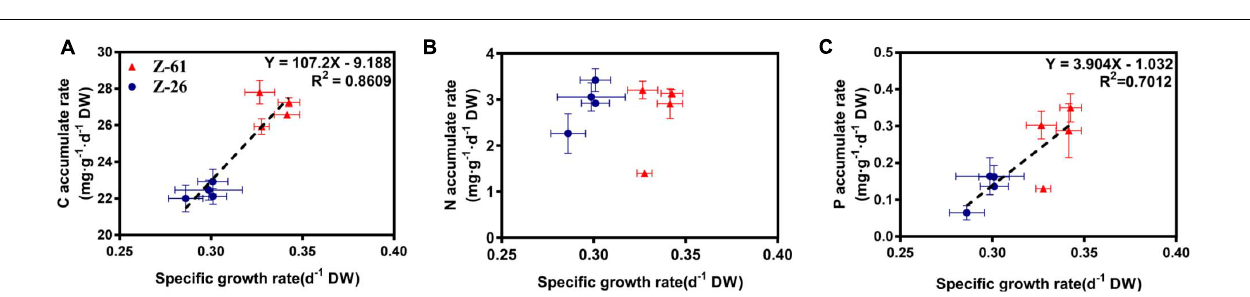
FIGURE 3 | The relationships between the specific growth rate and the accumulate rates of tissue elements of two strains of P. haitanensis : tissue carbon (A) , nitrogen (B) , and phosphorus (C)